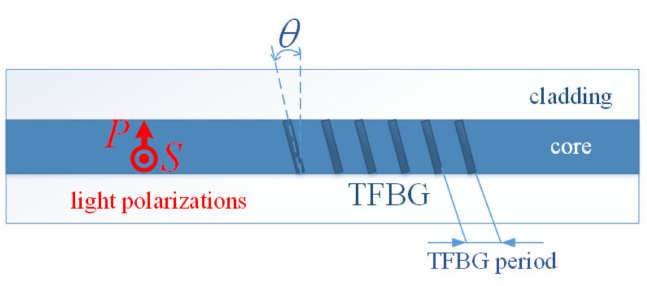
Figure 4. Marking of the two orthogonal polarization states in the TFBG structure.